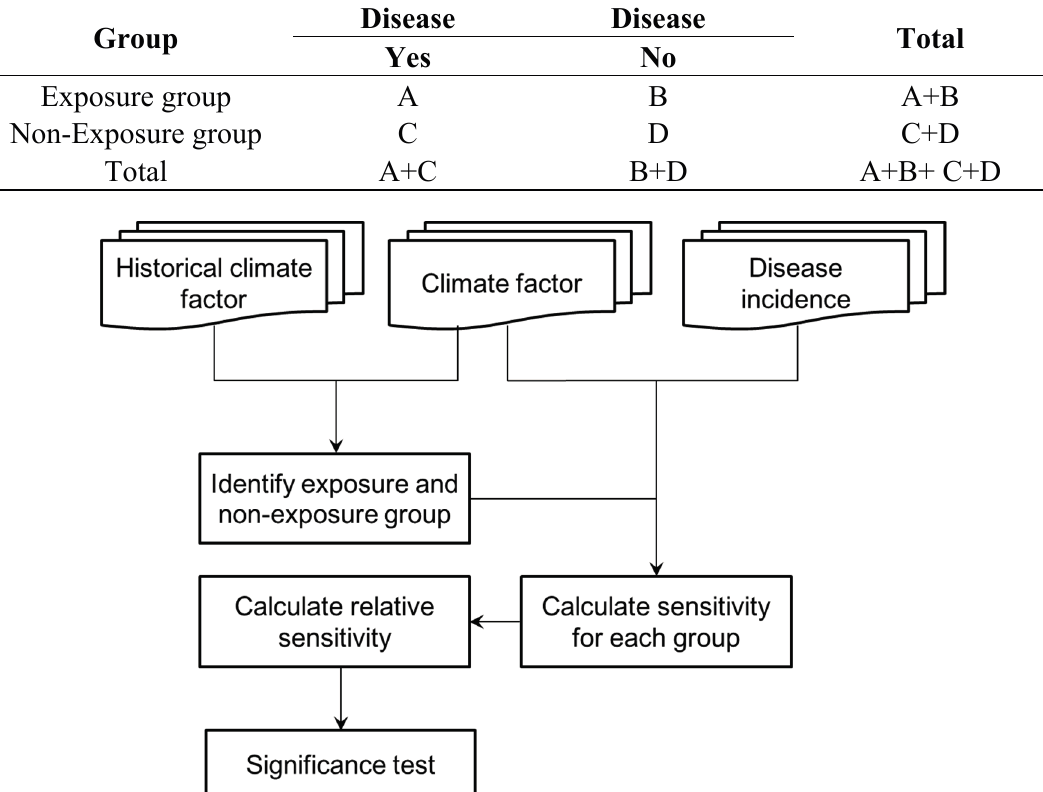
Figure 1. Flowchart of the calculation of Relative